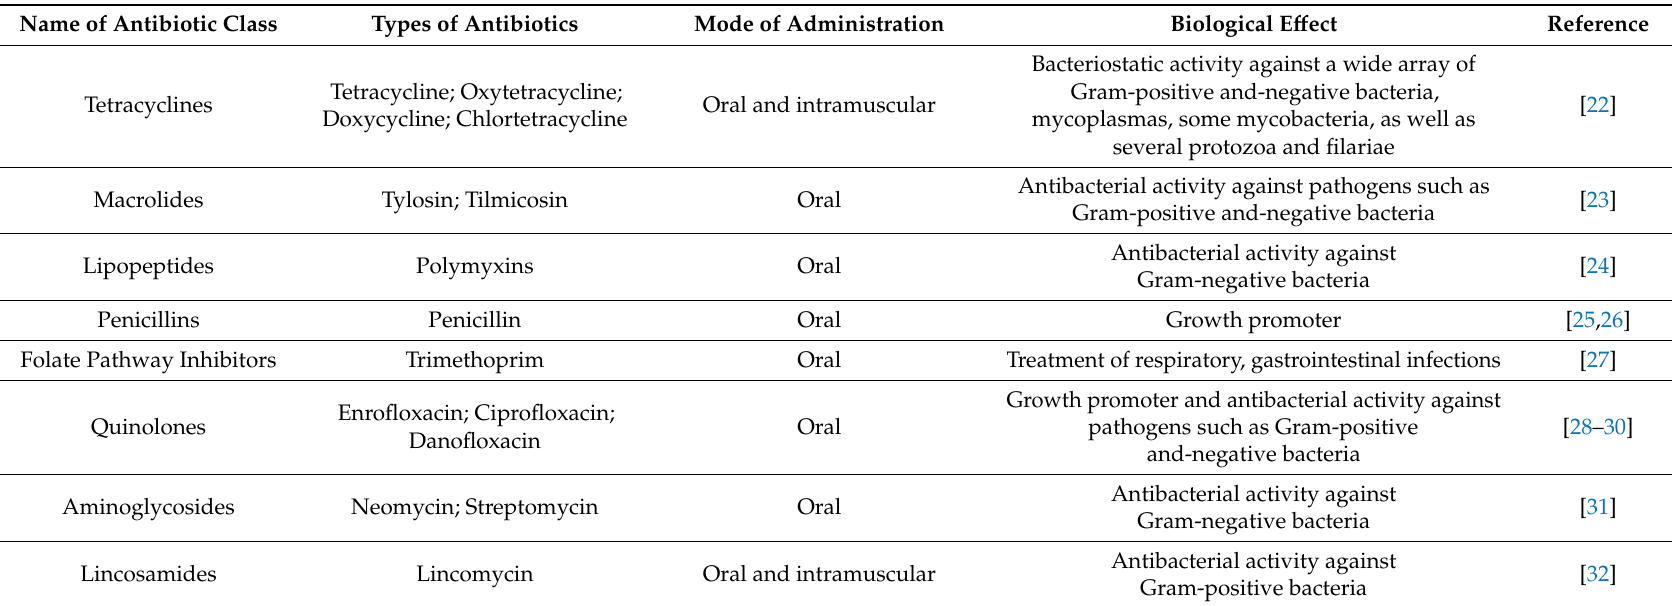
Table 2. Common antibiotics used in chicken